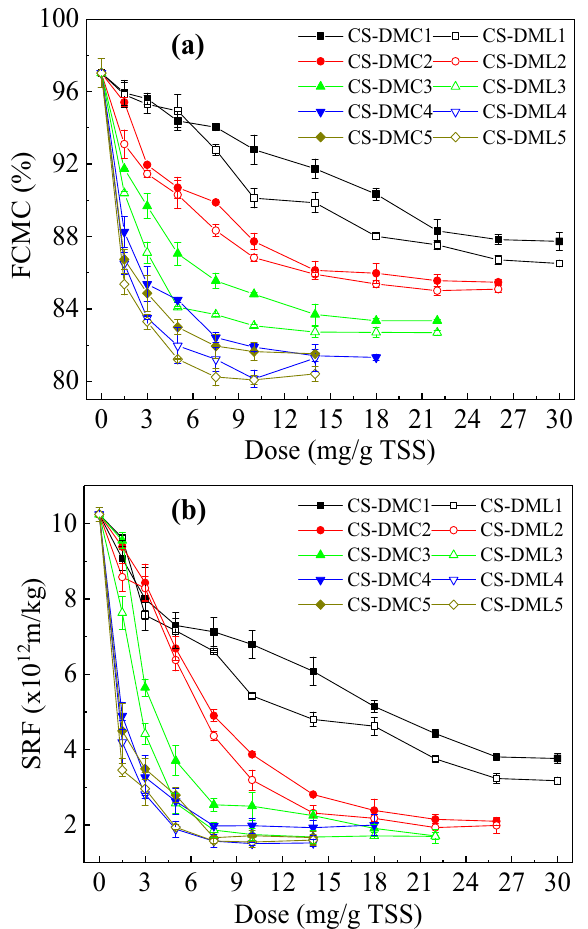
Figure 2. Dose effects of CS-DMCs and CS-DMLs on sludge dewatering performance: ( a ) FCMC and ( b )